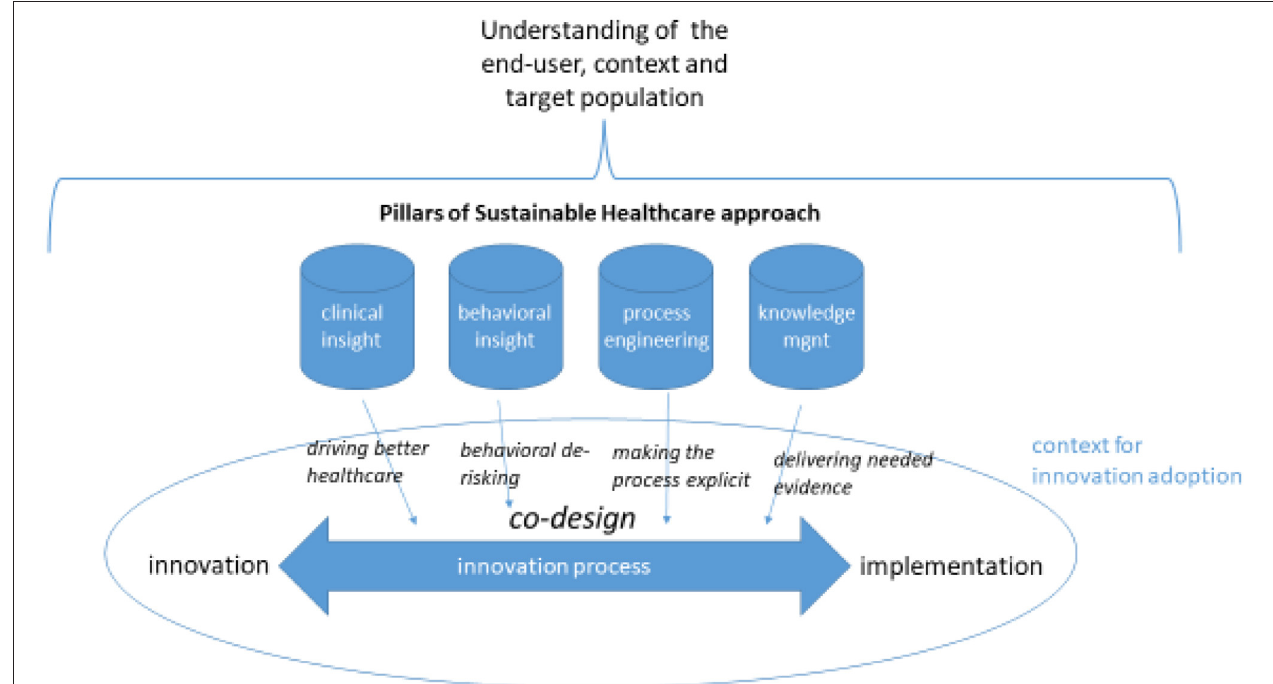
FIGURE 1 | NHS sustainable healthcare approach to digital